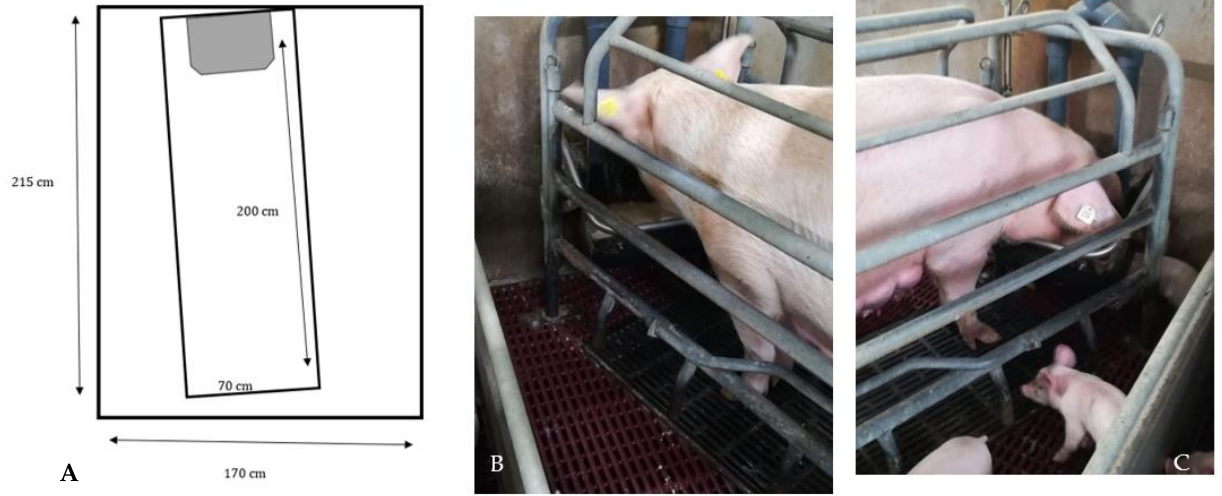
Figure 2. ( A – C ) Design and photos of the conventional farrowing crate